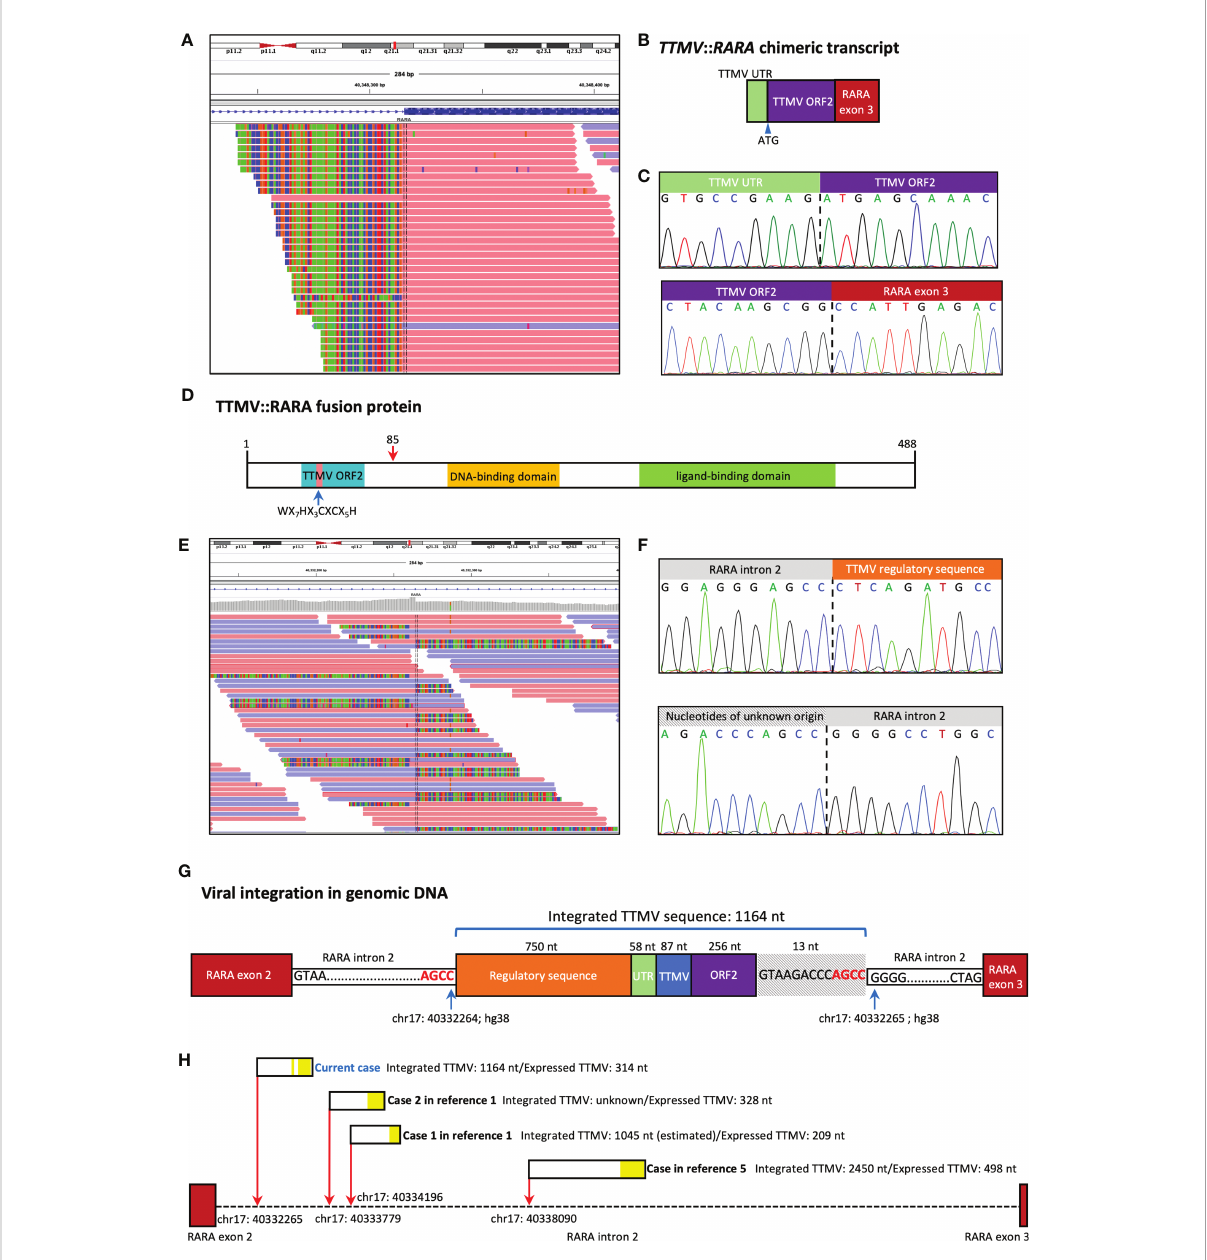
FIGURE 2 TTMV integration structure of our case. (A) Alignment of the whole transcript sequencing (WTS) data in integrative genomics viewer (IGV) revealed abundant RARA fusion transcripts with a 5 ’ extension from RARA exon 3, which is not homologous to any human sequence. (B) Schematic representation of the fusion between the TTMV sequence and RARA exon 3. The chimeric transcript includes TTMV open reading frame 2 (ORF2) and an upstream conserved untranslated region (UTR), in-frame with RARA exon 3. (C) Sanger sequencing con fi rmed the existence of the TTMV :: RARA fusion transcript. (D) The predicted structure of the TTMV::RARA fusion protein. The blue arrow indicates the highly conserved TTMV ORF2 motif. The red arrow at position 85 indicates the fusion site. (E) Whole genome sequencing (WGS) revealed the insertion was located at chr17: 40332265 (hg38) in RARA intron 2. (F) Sanger sequencing con fi rmed the two genomic junction sequences. (G) Schematic representation of the location and structure of the integrated TTMV sequence. (H) TTMV insertion characteristics in the 4 cases reported to date. The red arrows show the insertion positions of TTMV sequence in RARA intron 2 (hg38). The black rectangles show the integrated TTMV sequences, and the yellow blocks within them show the nucleotides expressed in the TTMV :: RARA fusion